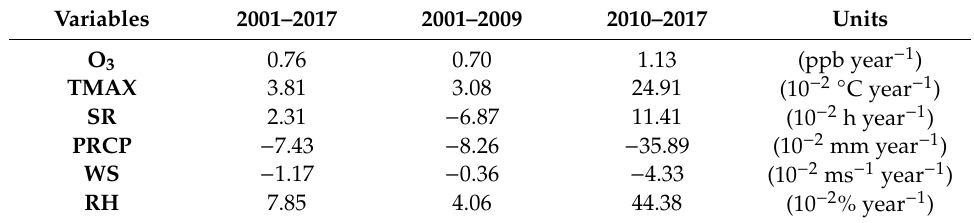
Figure 4. Long-term variability of O 3 (black) and meteorological factors, which maximum temperature (TMAX) (red), solar radiation (SR) (yellow), precipitation (PRCP) (blue), wind speed (WS) (green) and relative humidity (RH) (sky blue) using KZ filters. The meteorological factors are normalized for comparison. Table 2. Long-term variability trends of O 3 and meteorological factors in different periods.